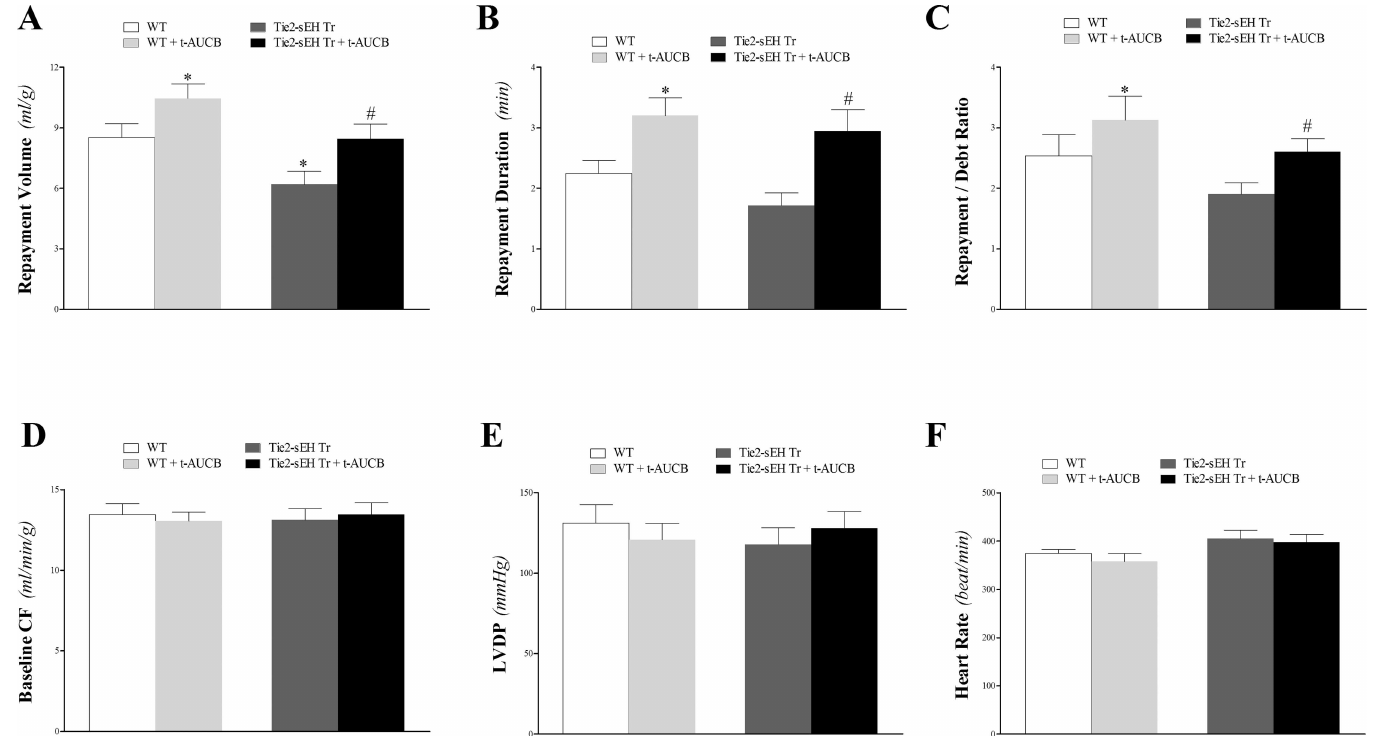
Fig 2. Effect of the sEH-inhibitor ( t -AUCB,10 μ M) on coronary reactive hyperemia (CRH) in Tie2-sEH Tr and WT mice. The sEH-inhibitor, t -AUCB, enhanced CRH in both Tie2-sEH Tr and WT mice. Repayment volume (A), repaymentduration(B), and repayment/debt ratio (C) were increasedin both strains. Repayment volume was decreased more in Tie2-sEH Tr compared to WT mice. BaselineCF (D), LVPD (E), and HR (F) were not different between the two groups. * P < 0.05 versus WT. # P < 0.05 versus t -AUCB–treated WT. n = 8 per